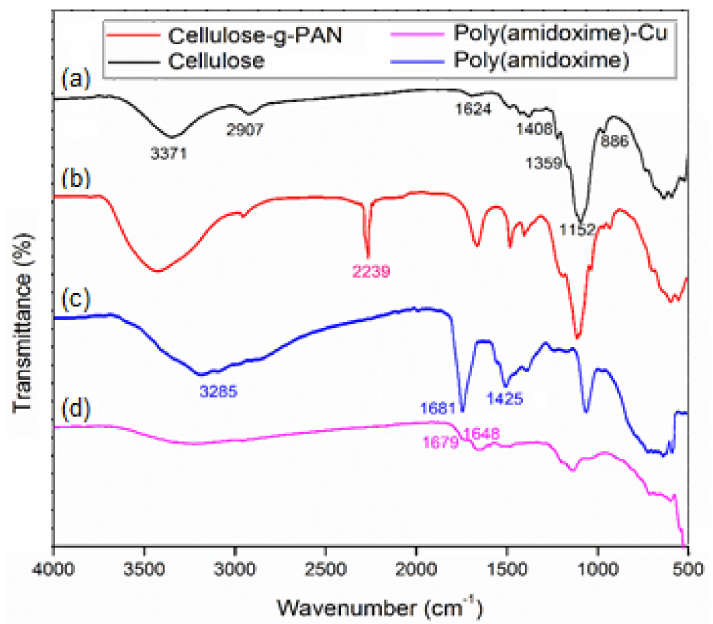
Figure 1. FT-IR spectra of ( a ) waste fiber cellulose, ( b ) cellulose-graft-poly(acrylonitrile) (cellulose-g- PAN), ( c ) poly(amidoxime) and ( d ) amidoxime-copper by coordination